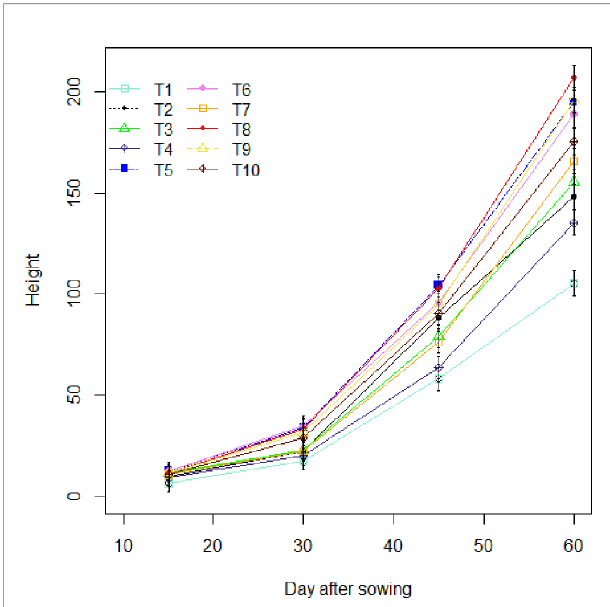
FIGURE 2 | Height variation as a function of fi eld-world treatments. T1, Control; T2, Glomeraceae; T3, Acaulosporaceae; T4, 25% NPK + urea; T5, Glomeraceae + 25% NPK+ urea; T6, Acaulosporaceae + 25% NPK+ urea; T7, 50% NPK + urea; T8, Glomeraceae + 50% NPK+ urea ;